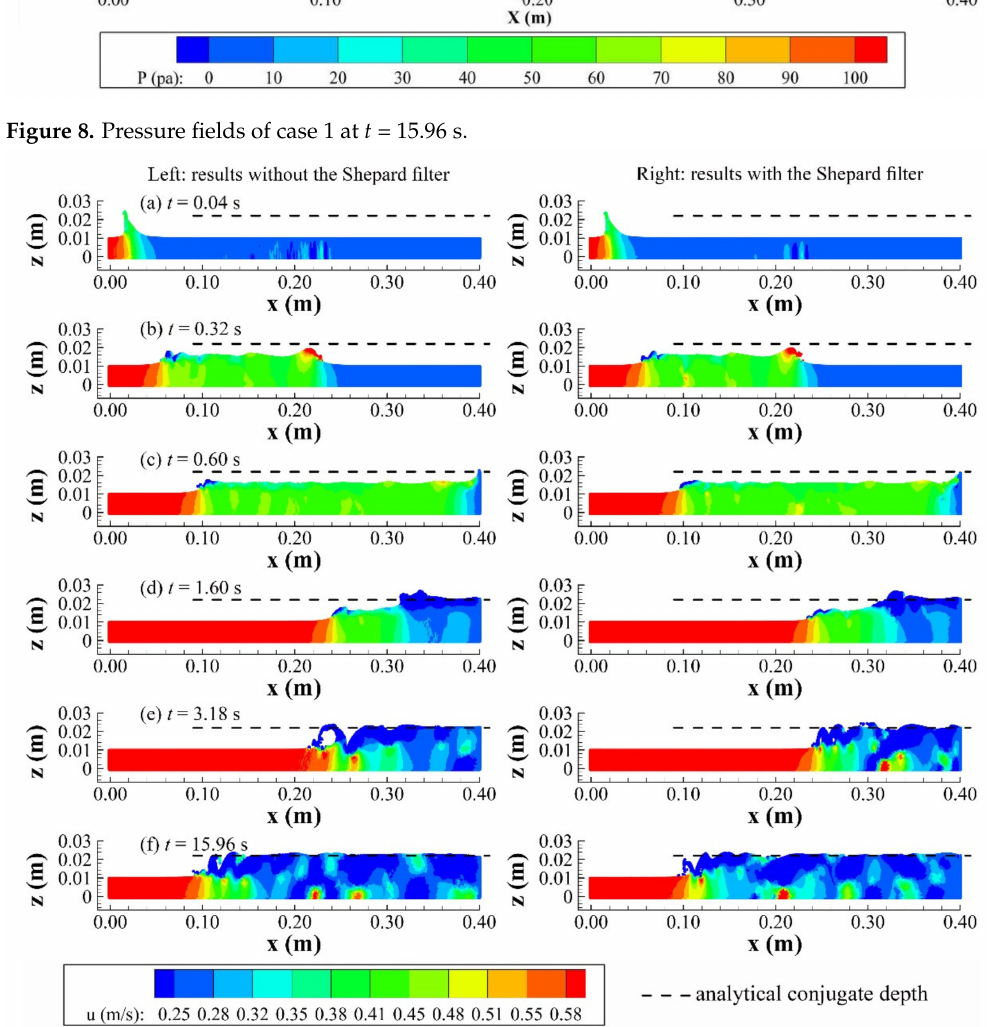
Figure 9. Velocity fields of case